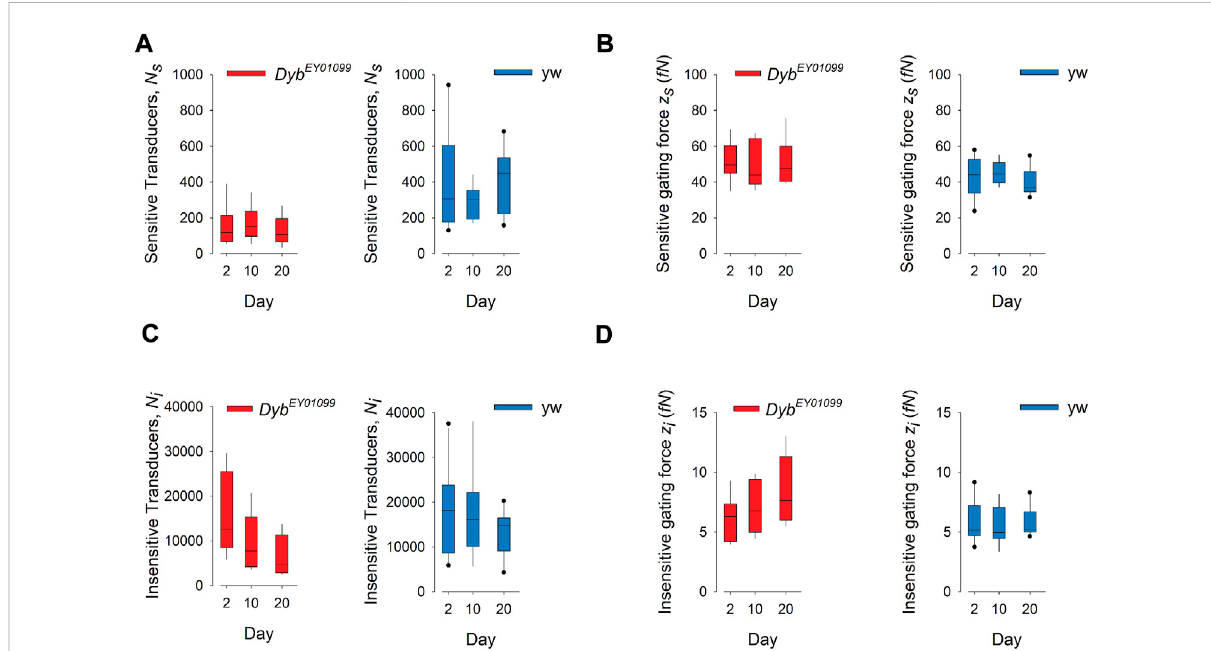
FIGURE 4 Mechanotransduction in Dyb EY01099 mutantsisimpaired inasubmodality-speci fi cway. (A) The number(Ns)ofsensitive(auditory) transducers is signi fi cantly ( p < 0.05) reduced in Dyb EY01099 (left) as compared to their yw controls (right) across all ages tested (day 2: p = 0.026; day 10: p = 0.0115, day 20: p = 0.000752). No progressive, age-dependent loss of sensitive transducers is observed in either mutants or controls ( p = 0.632 and p = 0.470, respectively; Kruskal – Wallis One Way ANOVA on Ranks; n = 10 each). (B) The gating force (z s ) of sensitive transducers is signi fi cantly enhanced in Dyb EY01099 (left) as compared to their yw controls (right) at day 20 but unchanged before (day 2: p = 0.143; day 10: p = 0.36, day 20: p = 0.028). No signi fi cant progressive, age-dependent change of gating force is observed (mutants: p = 0.819; controls: 0.276). (C) The number (Ni) of insensitive (wind/gravity) transducers is signi fi cantly ( p < 0.05) reduced in Dyb EY01099 (left) as compared to their yw controls (right) across all